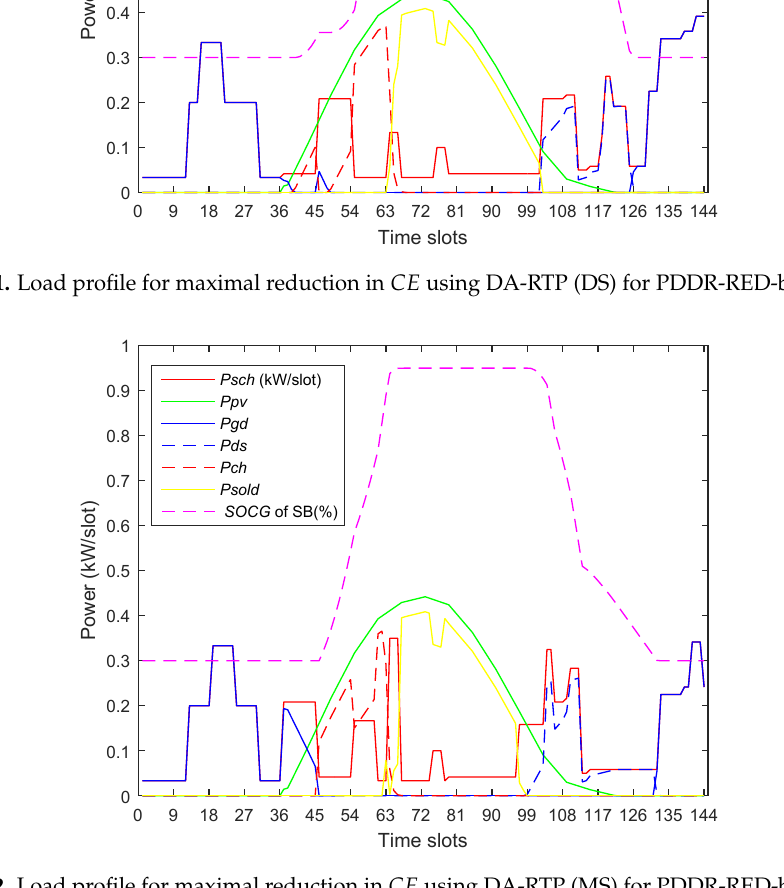
Figure 32. Load profile for maximal reduction in CE using DA-RTP (MS) for PDDR-RED-based